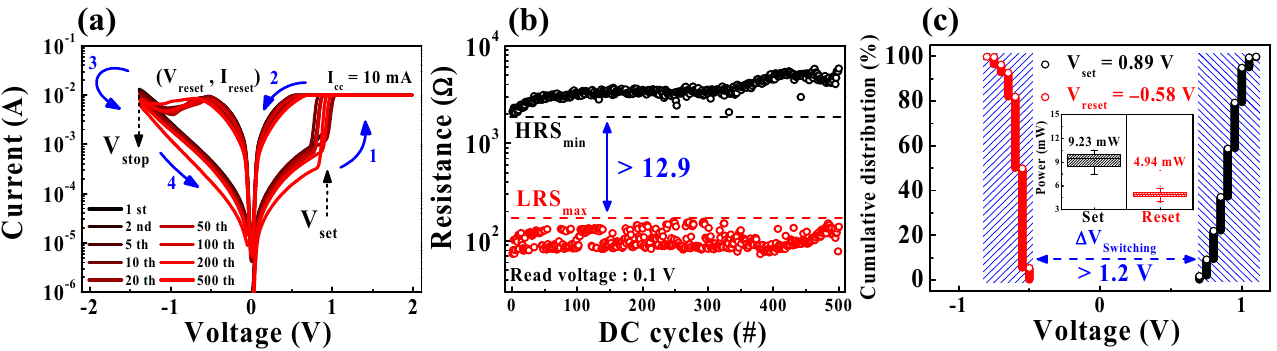
Figure 1. ( a ) Optical transmittance spectra of as-dried, 50 °C baked, and 80 °C baked solid polymer electrolyte (SPE)-chitosan layers on the glass substrate. The insets show the transmittance spectra in the visible light wavelength region (400–800 nm) and a photograph of the 80 °C baked SPE-chitosan layer. ( b ) Bipolar resistive switching (BRS) I - V characteristics of as-dried, 50 °C baked, and 80 °C baked SPE-chitosan memristors.